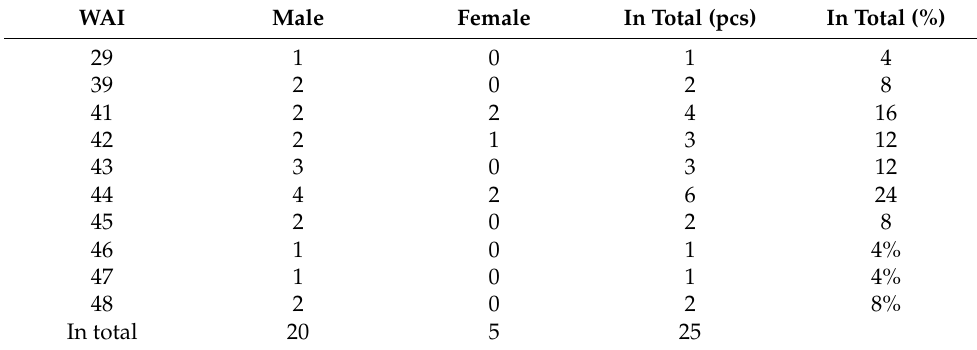
Table 3. Work Ability